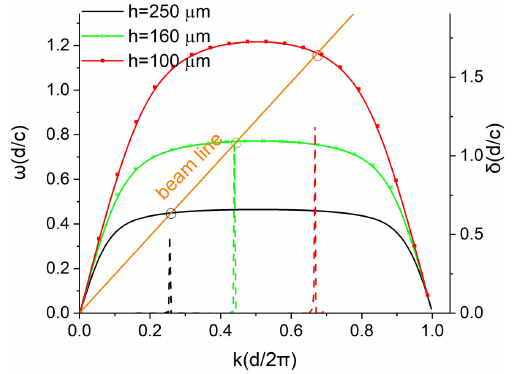
Figure 3: Comparison of dispersion relation for different grating heights, when ε r = 2 . 7. The growth rate cor- responding to each frequency curve is plotted by dash lines, and maximum values are indicated at the circle points.